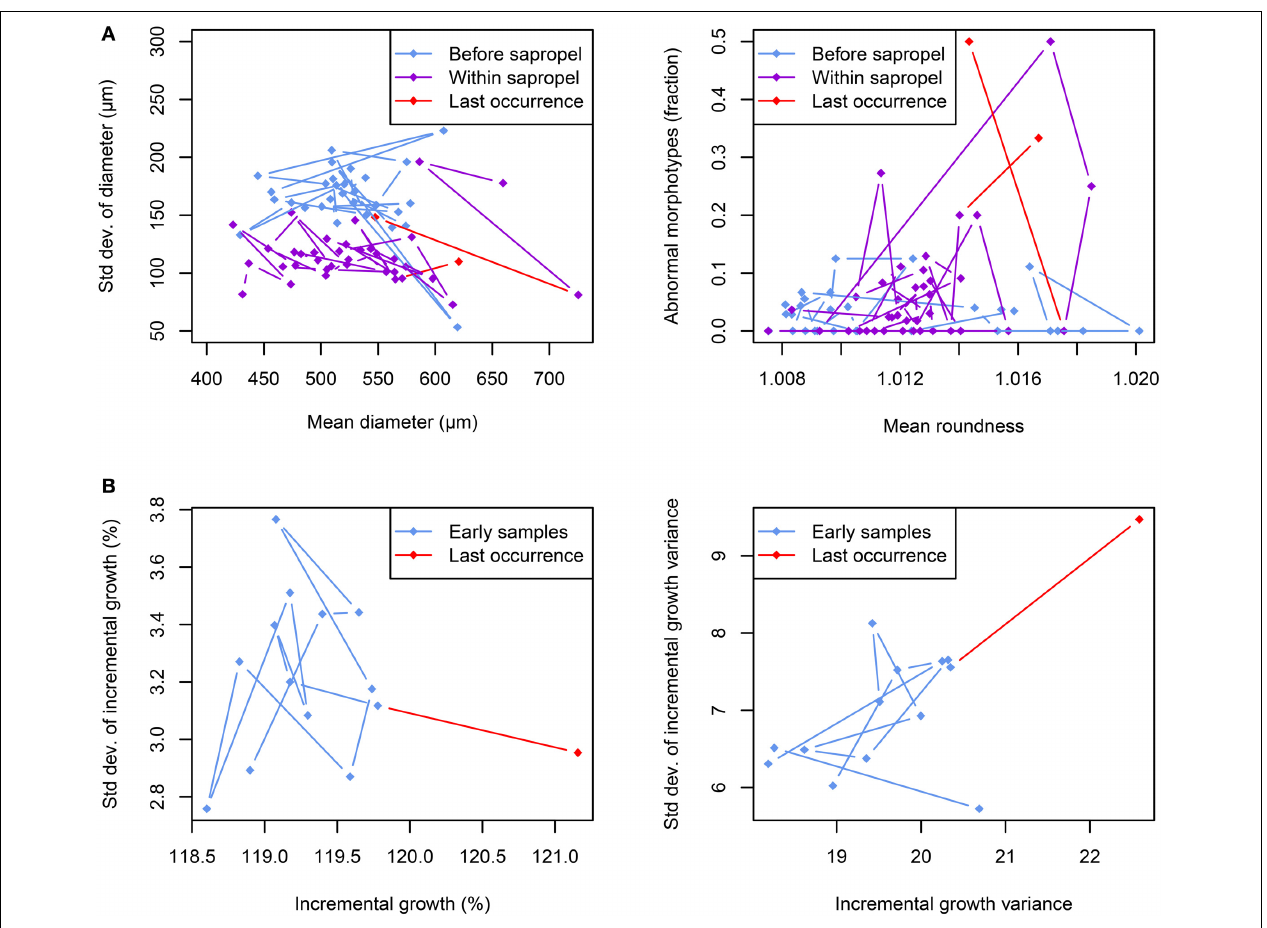
FIGURE 7 | Morphological trends in foraminiferal shells during extinction periods. (A) Evolution of size and roundness and incidence of abnormal morphotypes in Orbulina universa across the onset of the Sapropel S5 deposition in core M51-3/SL104. The shell diameter shows no change with sapropel onset, but size variability is reduced within the sapropel. In contrast, shells within the sapropel are on average significantly less round than for the majority of the time before sapropel onset. The incidence of abnormal